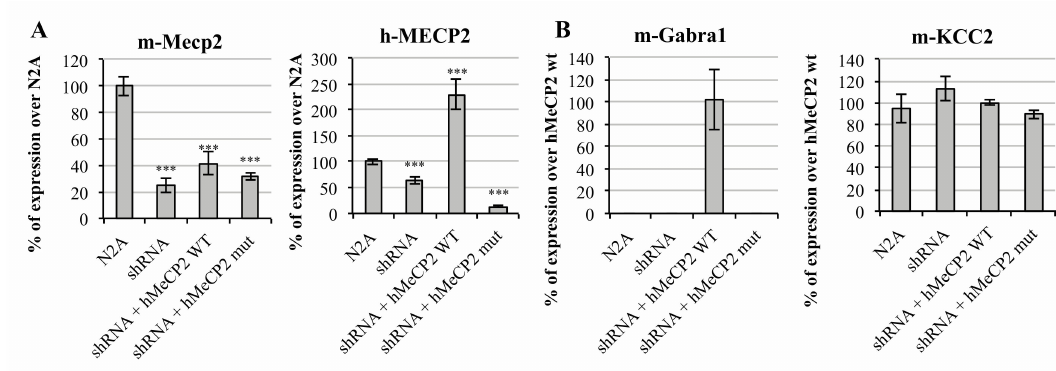
Figure 1. In vitro analysis of MeCP2 altered activity over γ -aminobutyric acid (GABA) ionotropic receptors’ expression. Bar graph representing the relative expression of ( A ) mouse MECP2 (mMeCP2), human MECP2 (hMeCP2) and ( B ) mouse GABRA1, and mouse KCC2, measured by qRT-PCR under four di ff erent transfection scenarios, namely: non-transfected cells (N2A), transfected with the shRNA-anti-(3 (cid:48) UTR)Mecp2 (shRNA) and co-transfected with the shRNA-anti-(3 (cid:48) UTR)Mecp2 and wt , or c.763C > T mutated MeCP2 carrying plasmids. Error bars represent the standard deviation of the average values. Statistical significance was calculated through a Student’s t-test (*** p -value <